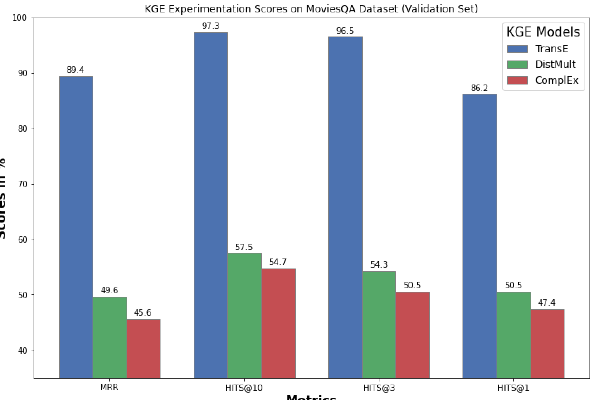
Figure 6. KGE Training Performance-Comparison between TransE, DistMult, and CompEx models on the modified triples in the WikiMovies dataset, measured in terms of MRR and HITS@N.